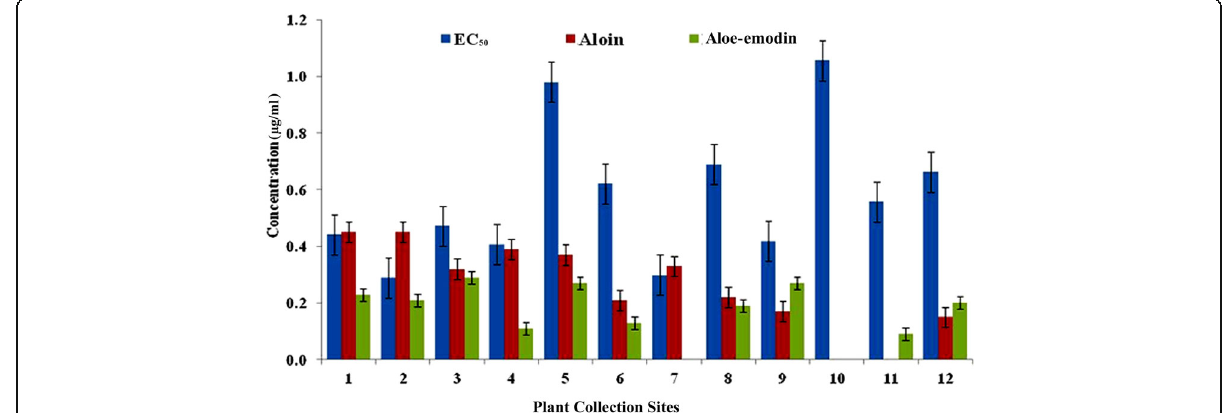
Fig. 3 Antiplasmodial EC 50 values, quantity of aloin and aloe-emodin from crude aqueous extracts of different Aloe vera